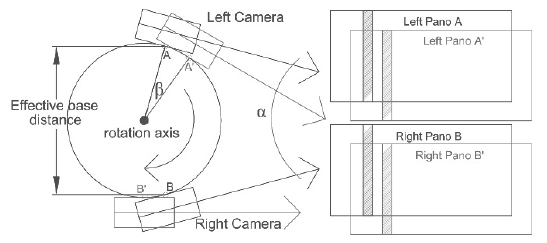
Figure 4: Virtual symmetric toed-in camera